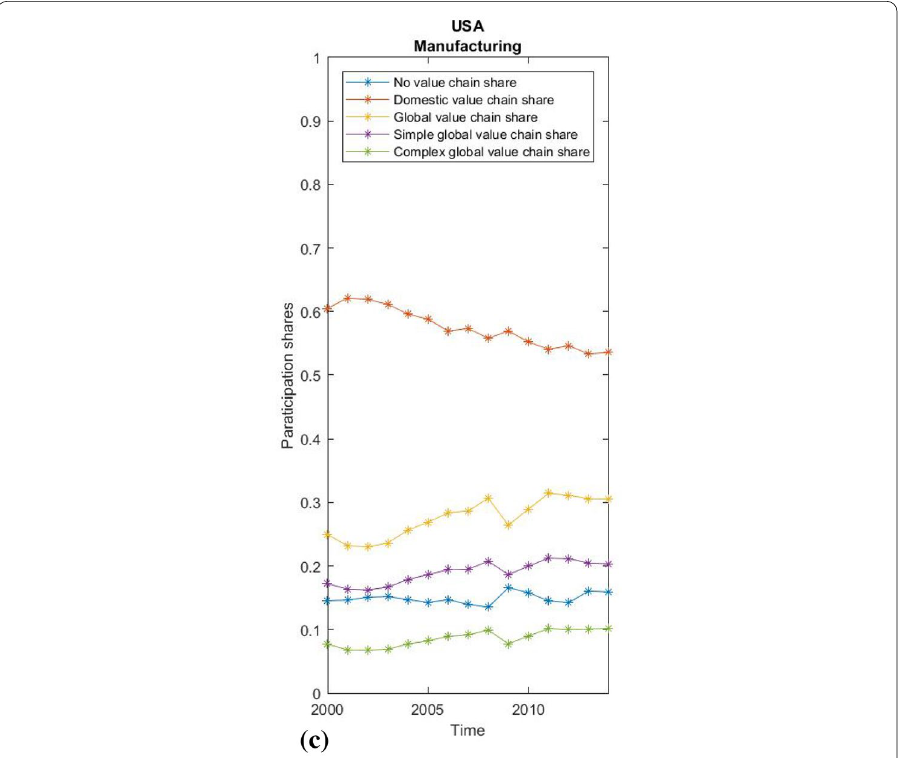
Fig. 7 USA manufacturing participation rates. creditSource: WIOD 2016; own calculations